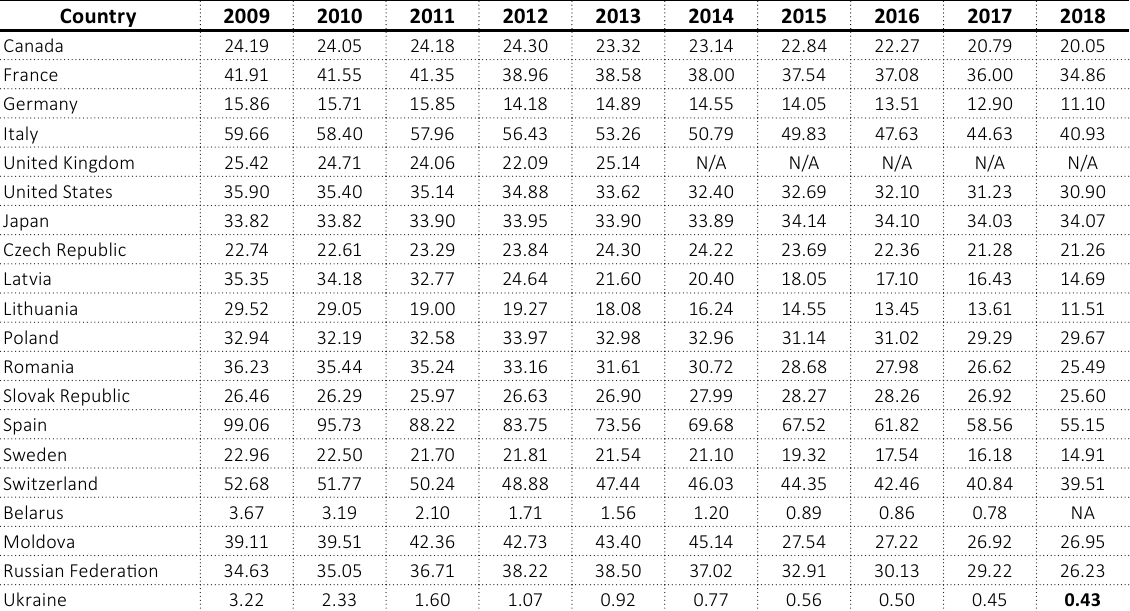
Source: Compiled based on the IMF data.